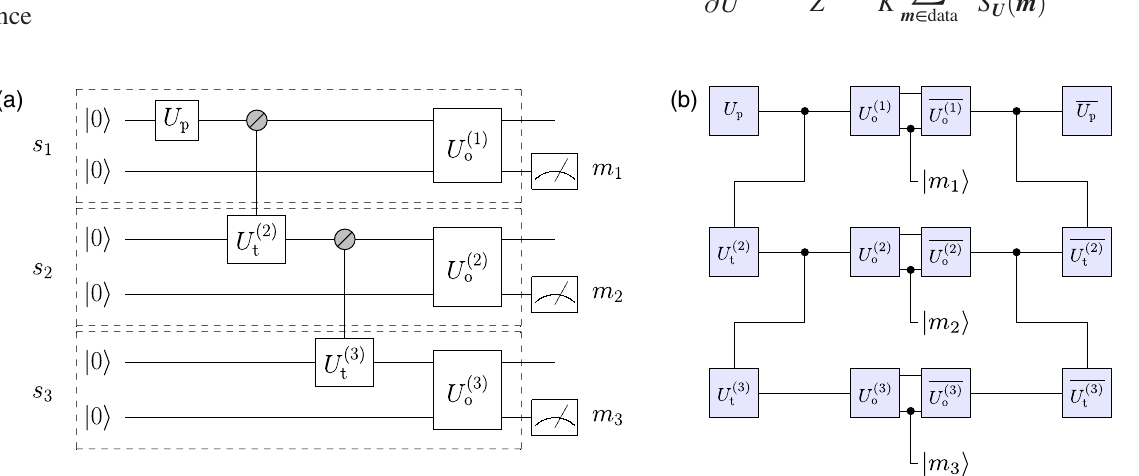
FIG. 6. (a) BBQC interpretation of a three-node 2-gram model, with states s 1 , s 2 , s 3 . An initial unitary U uniformly controlled unitaries CU encode transitions between 2-gram states. Each measurement is in some standard basis encoding of t the M -dimensional output space. To directly compare with classical HMMs, we only consider transfer unitaries on a k -dimensional subspace of each state (top wire), and we consider the distribution on an M subspace of each state (bottom wire). (b) Tensor network representation of the same quantum